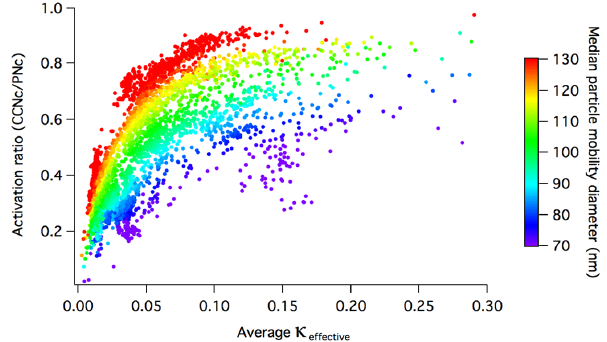
Figure 5. The activation ratio (CCNc / PNc) as a function of the ef- fective hygroscopicity parameter, κ . The colours represent the me- dian particle mobility